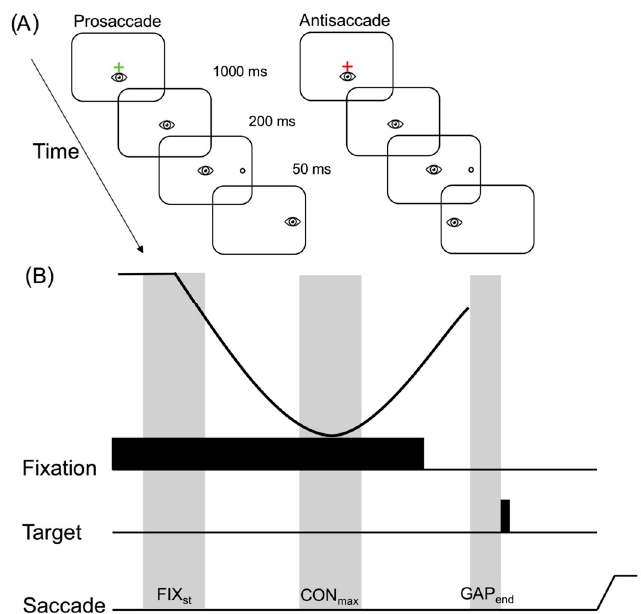
Figure 1. Panel A shows the timeline of visual and motor events for pro- and anti-saccades. A single target eccentricity is depicted to the right of the fixation; however, in the current study, two eccen- tricities were employed and the targets are presented left and right of the fixation. Panel B presents the epochs for the pupil analysis: fixation start (FIX st ; 100–300 ms after fixation onset), maximal pupil constriction (CON max ; 650–750 ms after fixation onset), and gap end (GAP end ; 150–200 ms after gap onset). The solid black line in Panel B depicts the time course change in the absolute pupil